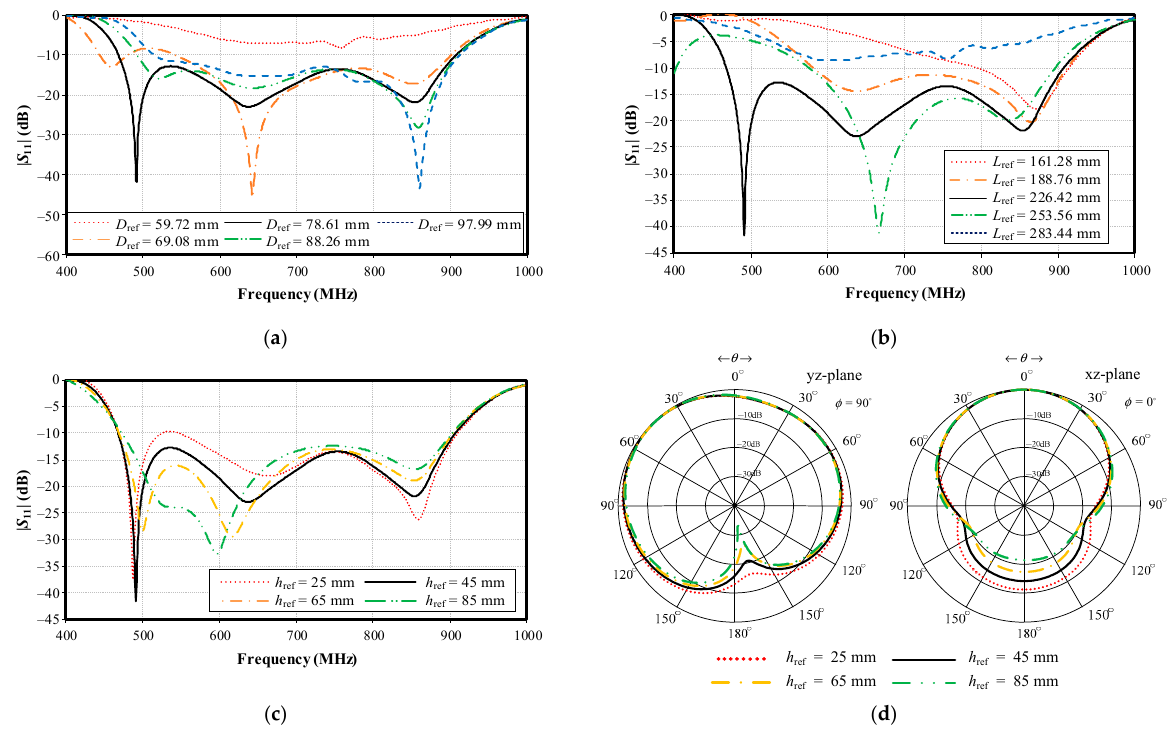
Figure 13. Simulated impedance bandwidth under variable parameters: ( a ) distance from center of the supporting plate to the reflector ( D ref ), ( b ) reflector length ( L ref ), ( c ) reflector height ( h ref ), and ( d ) radiation pattern at 890 MHz under variable h ref .